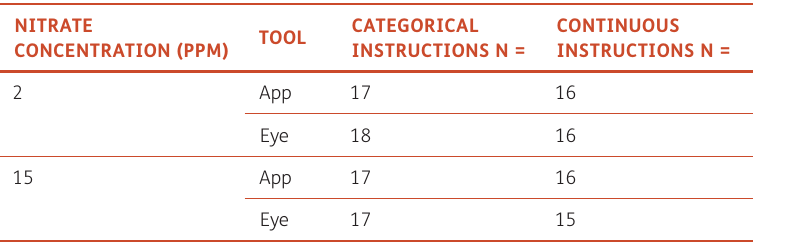
Table 2 Breakdown of volunteers using each quantification method using either categorical or continuous instructions to test their sample.